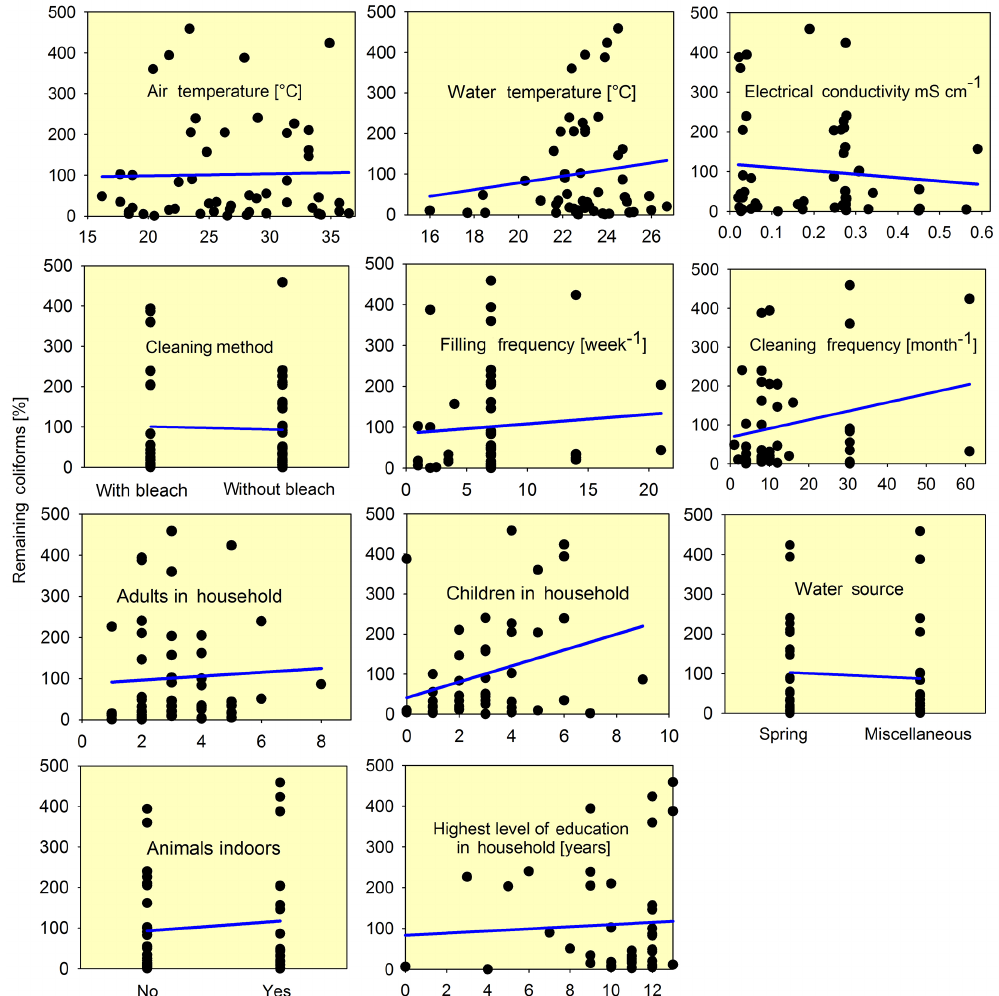
Figure 7. CCFS efficiency plotted against various factors included in the questionnaire; blue lines (linear regression) indicate the direction of